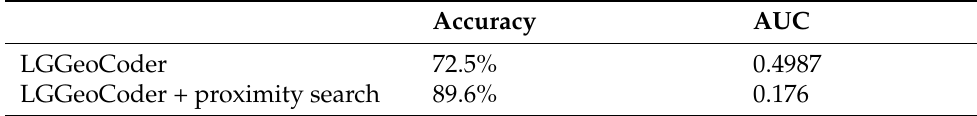
Table 2. The prediction performance of LGGeoCoder with proximity